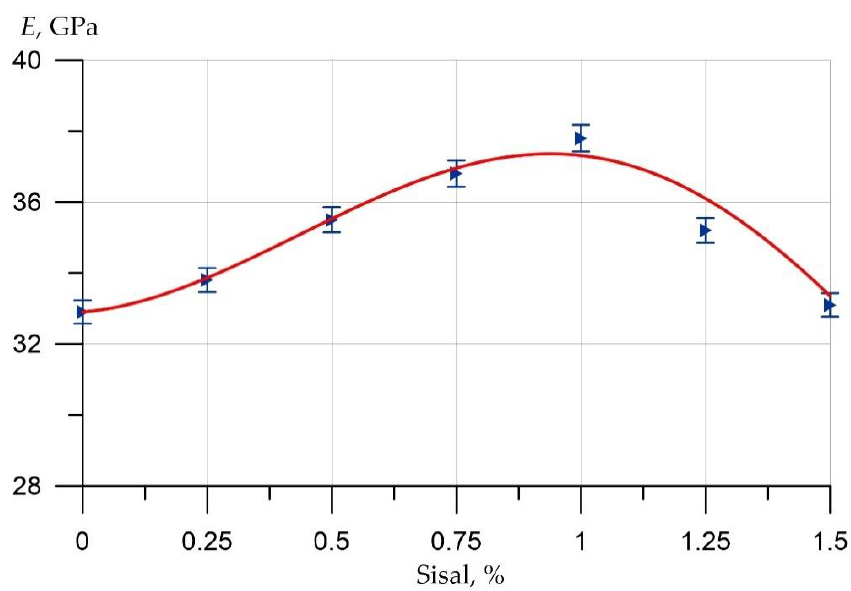
Figure 11. Results of experimental studies of the modulus of elasticity E of concrete samples in the form of prisms with various percentages of reinforcement with sisal fibers.